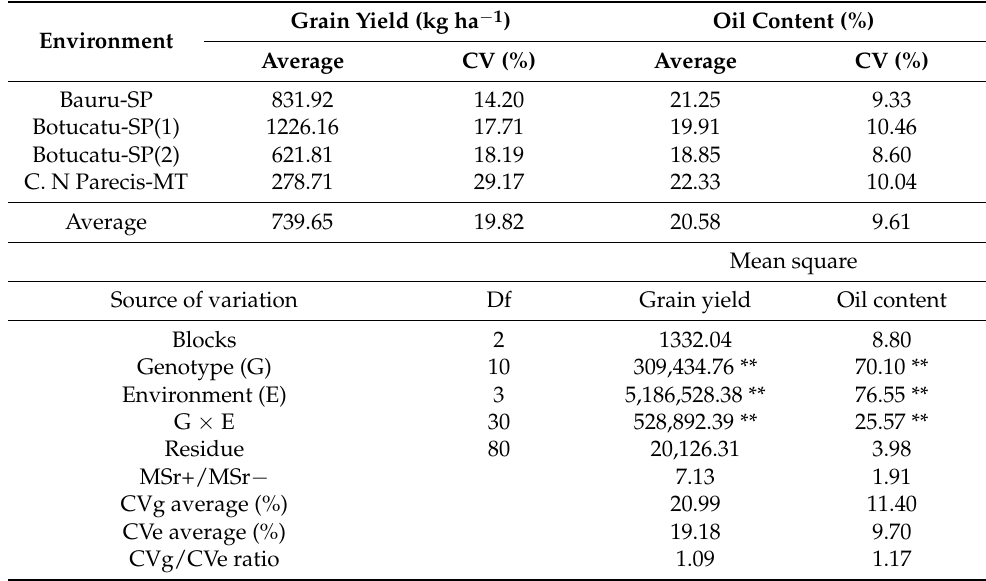
Table 2. Environment means and joint analysis of variance of safflower genotypes grown in four environments of the Brazilian